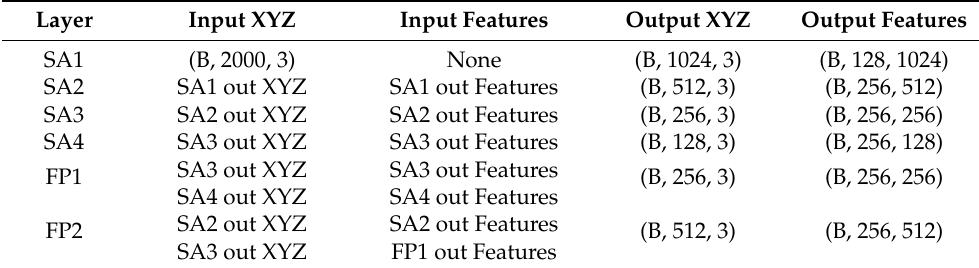
Table 2. Overview of the input and output for the backbone